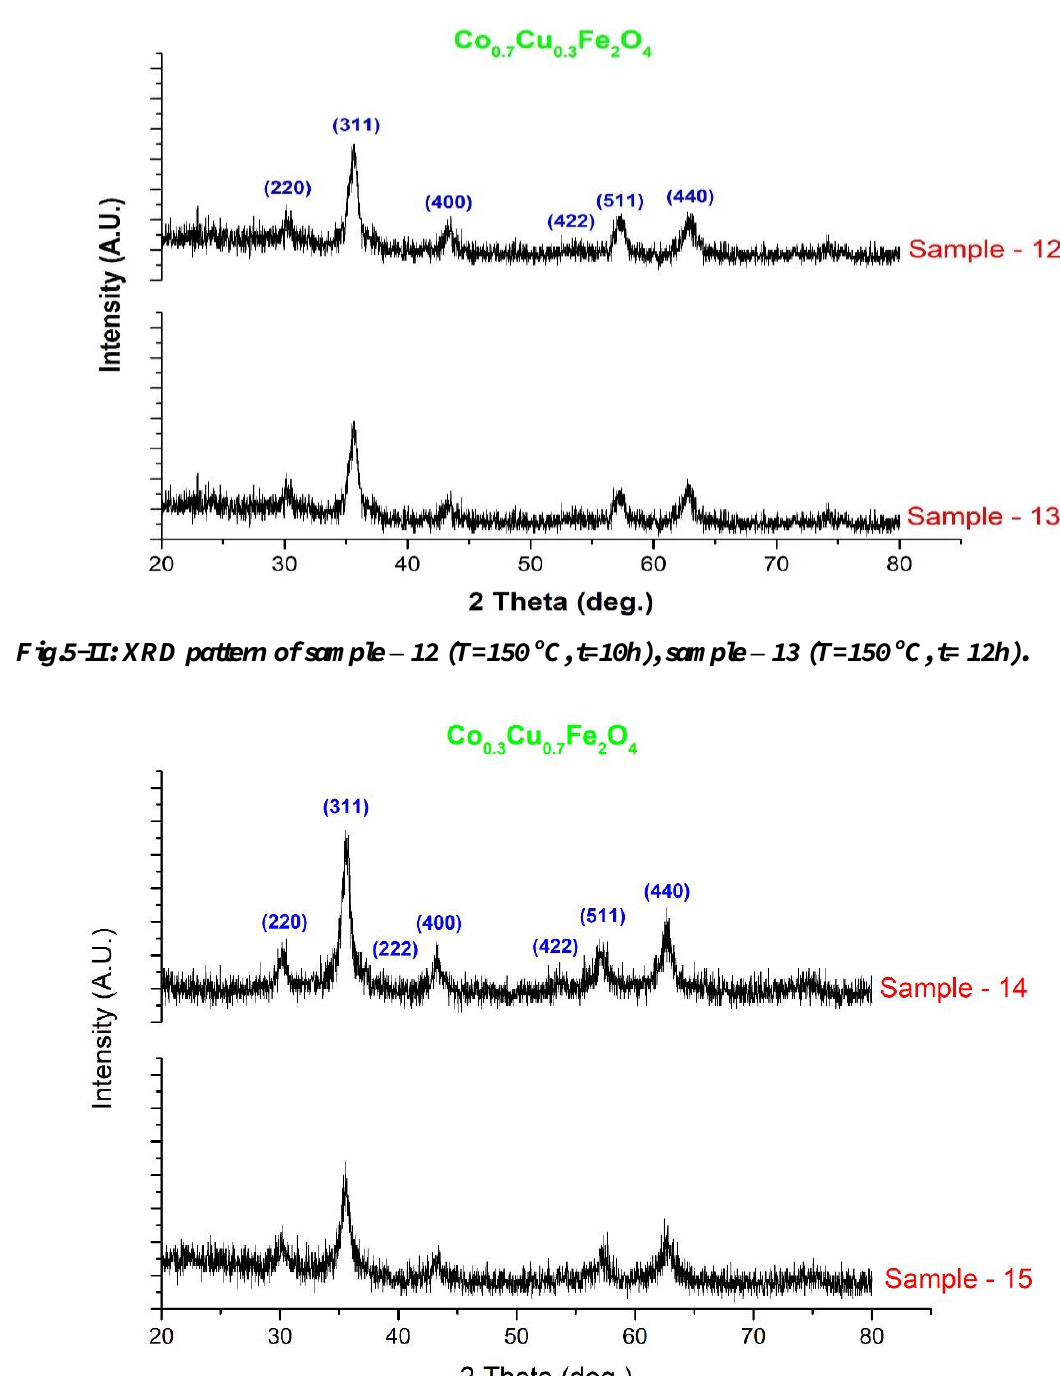
Fig.5-III: XRD pattern of sample – 14 (T=100 o C, t=10h), sample – 15 (T=100 o C, t=